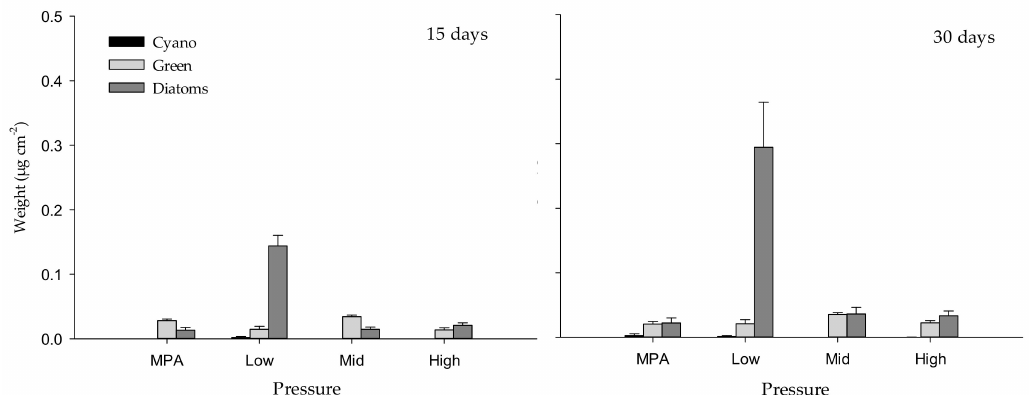
Figure 1. Weight ( µ g cm –2 ) of cyanobacteria (Cyano), chlorophyll a (Green) and diatoms measured with BenthoTorch) among “Pressure” levels after 15 and 30 days of